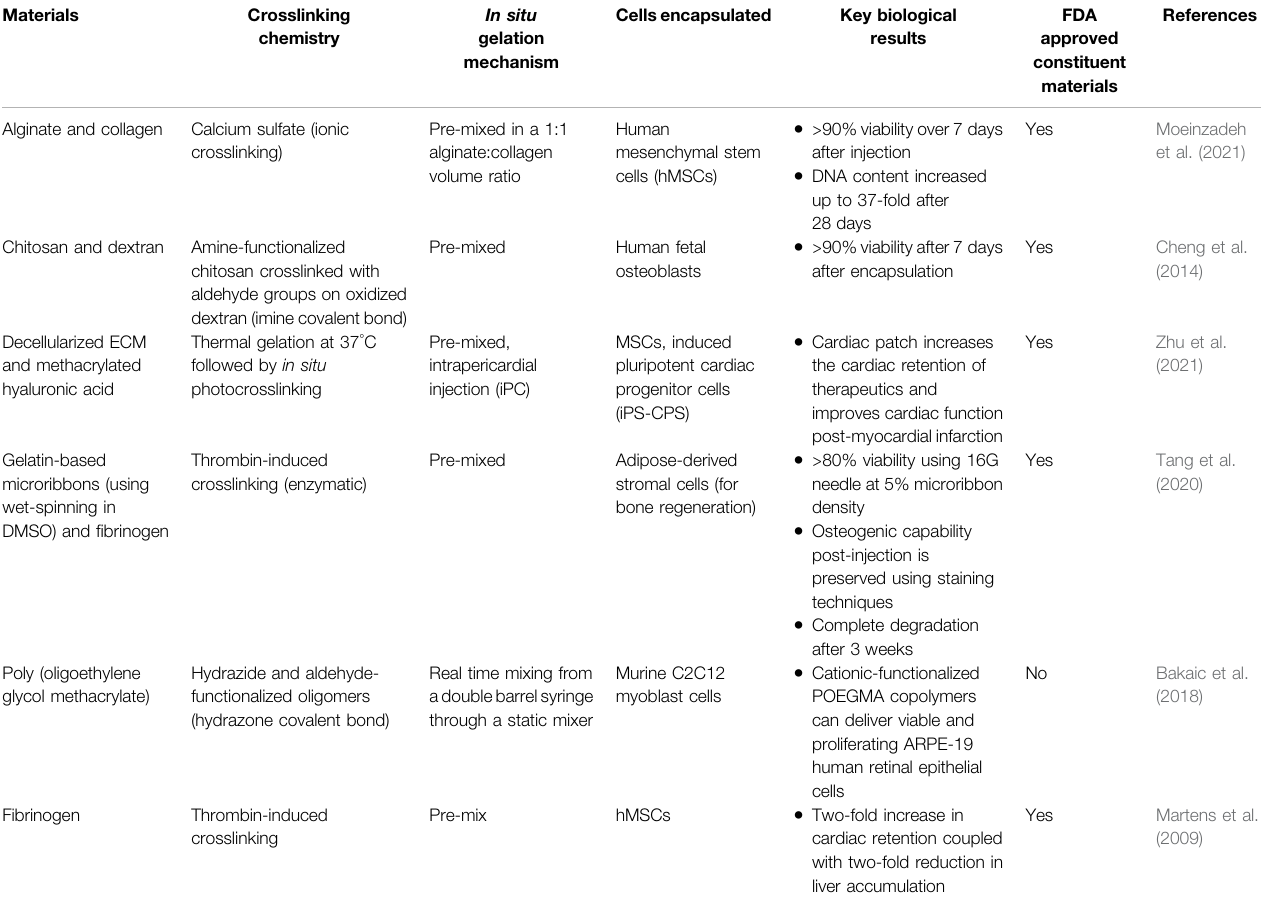
TABLE 2 | Materials and methods used for in situ tissue